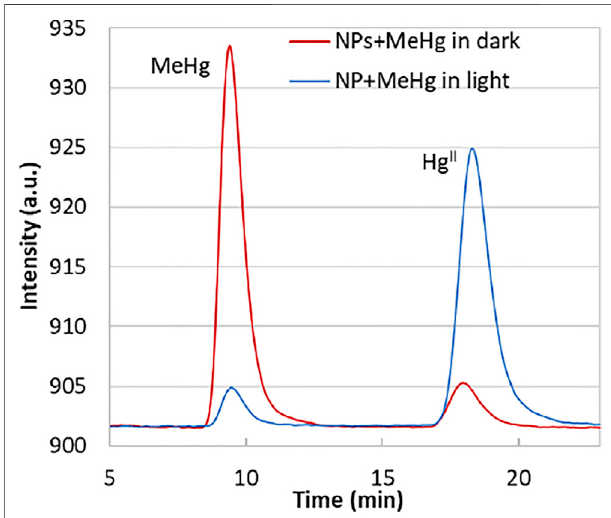
FIGURE3| Mercuryatomic fl uorescencespectrafromtheTekran2700. The peakMeHgrepresents methylethylmercurysourced frommethylmercury by derivitization; Hg II represents the diethyl mercury produced from Hg II . The lines represent the spectra of bulk solutions from the higher concentration additions. For the exposure in the dark (red line), the peak area of MeHg (cid:1) 3,550; Hg II (cid:1) 126; for the light exposure (blue line), MeHg (cid:1) 110; Hg II (cid:1)